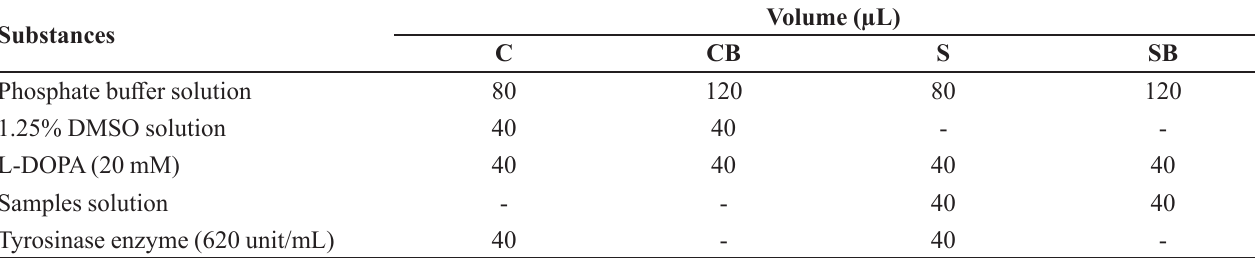
C = Control, CB = Control-Blank, S = Sample, SB =